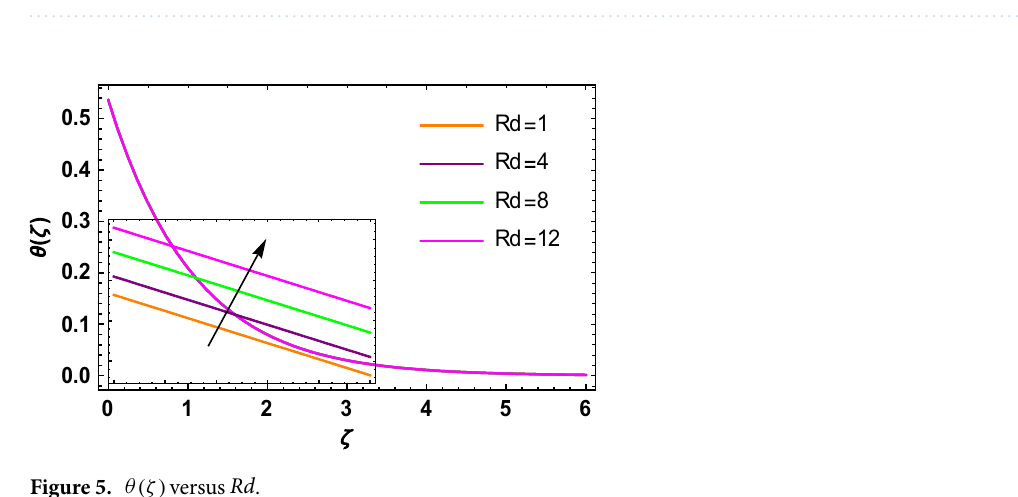
Figure 5. θ(ζ) versus Rd